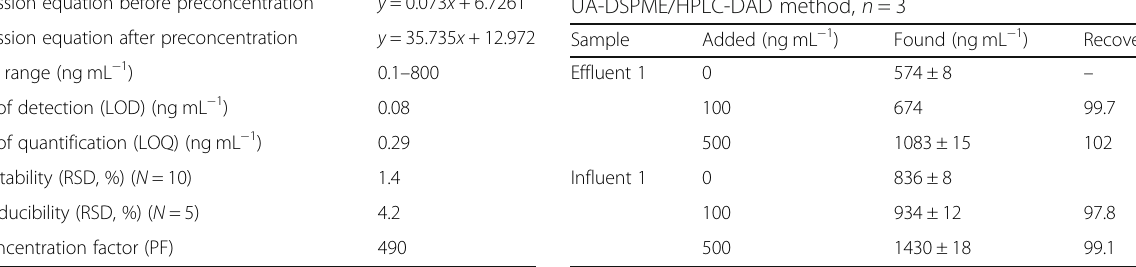
Table 4 Recoveries of CBZ from wastewater samples spiked at two levels (100 ng mL − 1 and 500 ng mL − 1 ) using the